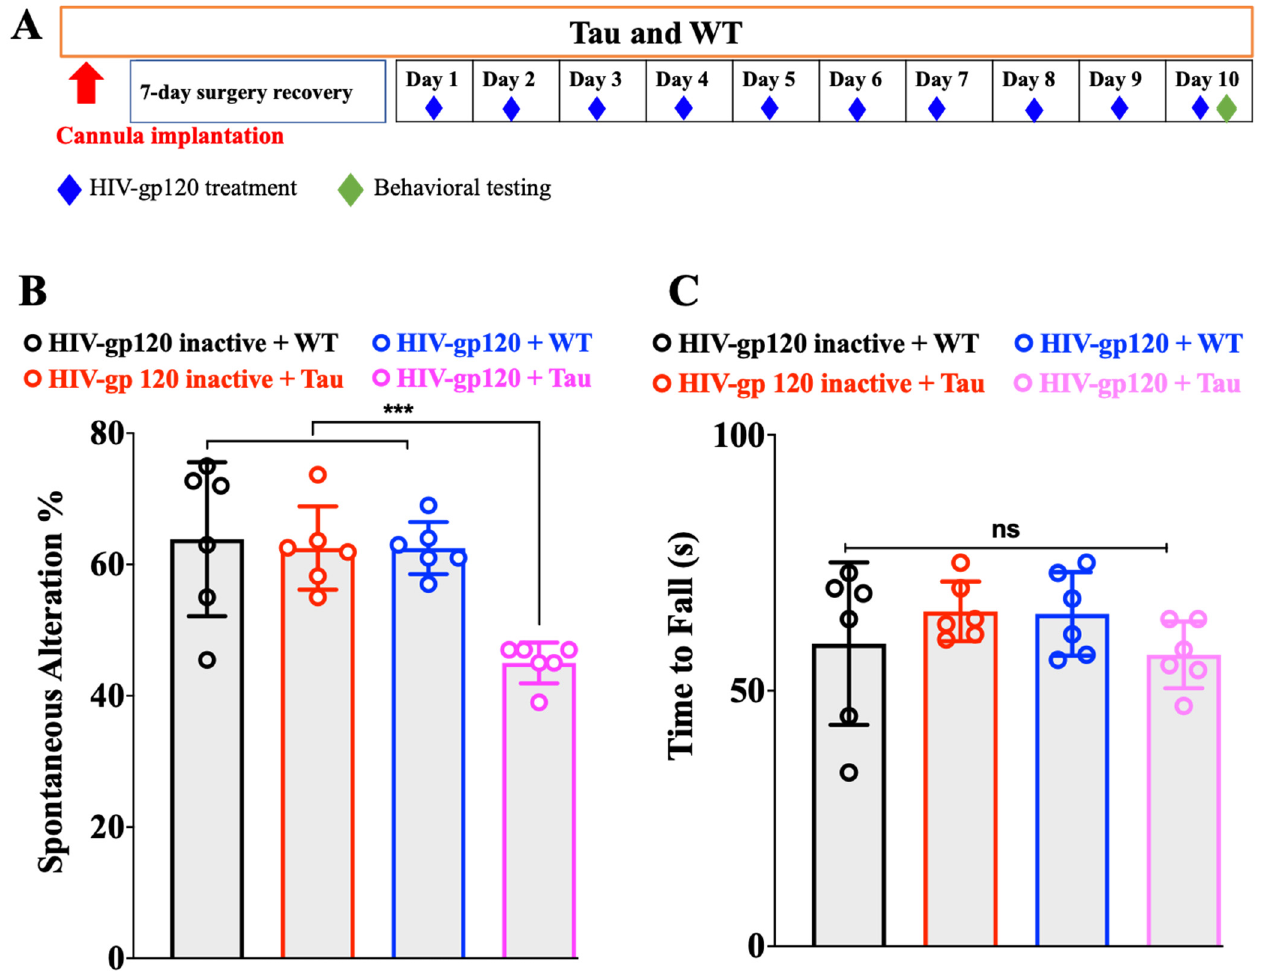
Figure 1. ( A ) Experimental design. ( B ) HIV-gp120 promoted the onset of cognitive deficit of Tau mice. Effects of HIV-gp120 on motor coordination ( C ). *** p < 0.001, ns: not significant. Data are presented as mean ± SEM.